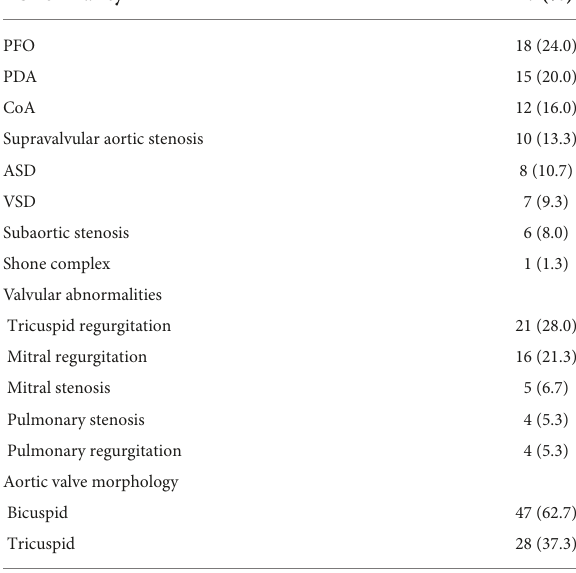
TABLE 1 Concomitant cardiovascular anomalies and aortic valve morphology in children who underwent AoV